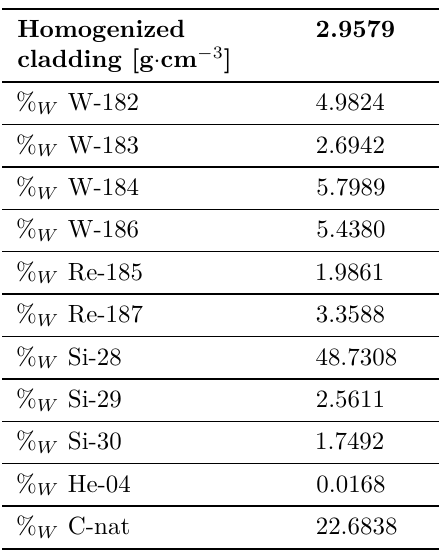
Table 4. Homogenized cladding material composi- tion [16].